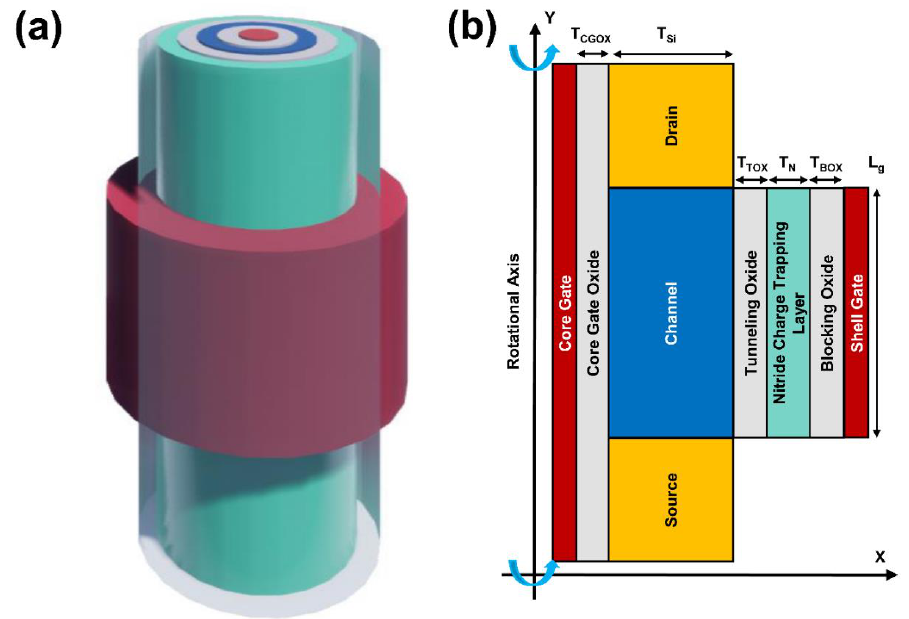
Figure 1. ( a ) The schematic image and ( b ) the cross-sectional view of a core – shell dual-gate nanowire nanowire neuron.